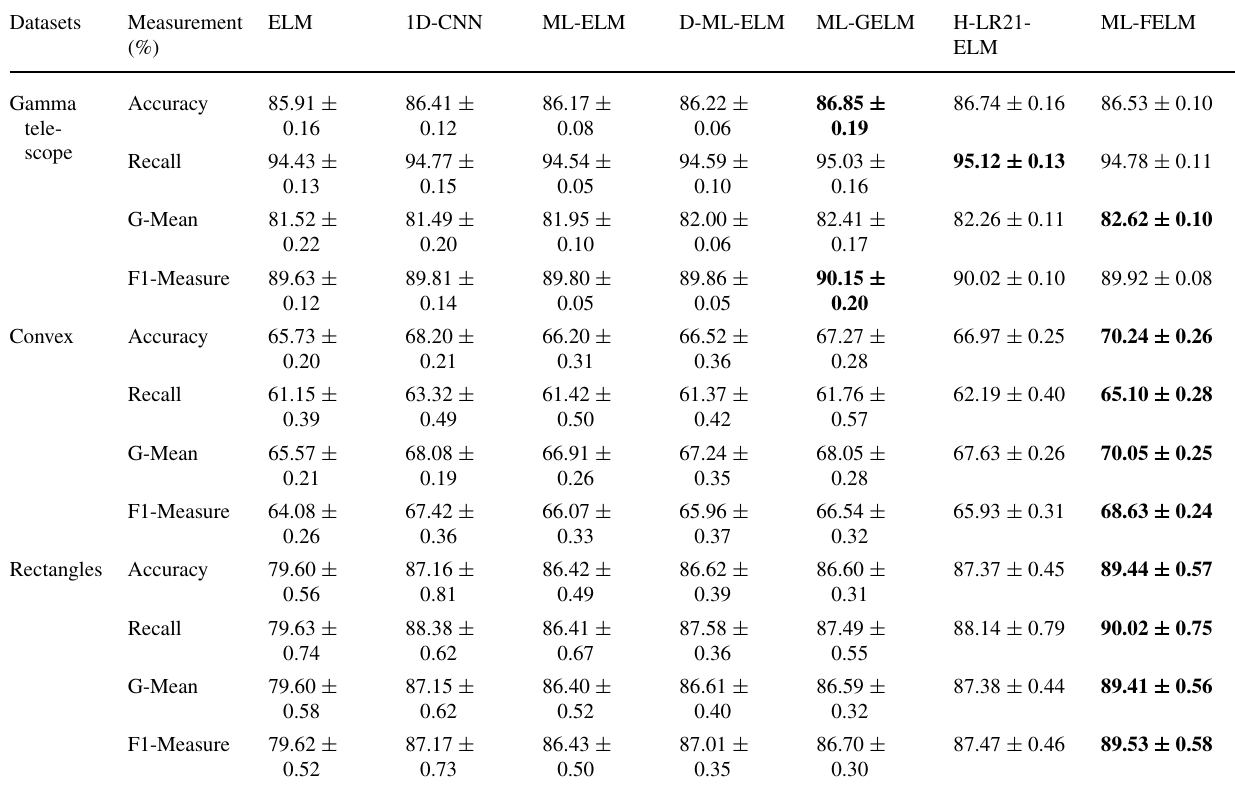
Table 4 The performance comparison of each algorithm for binary classification tasks Datasets